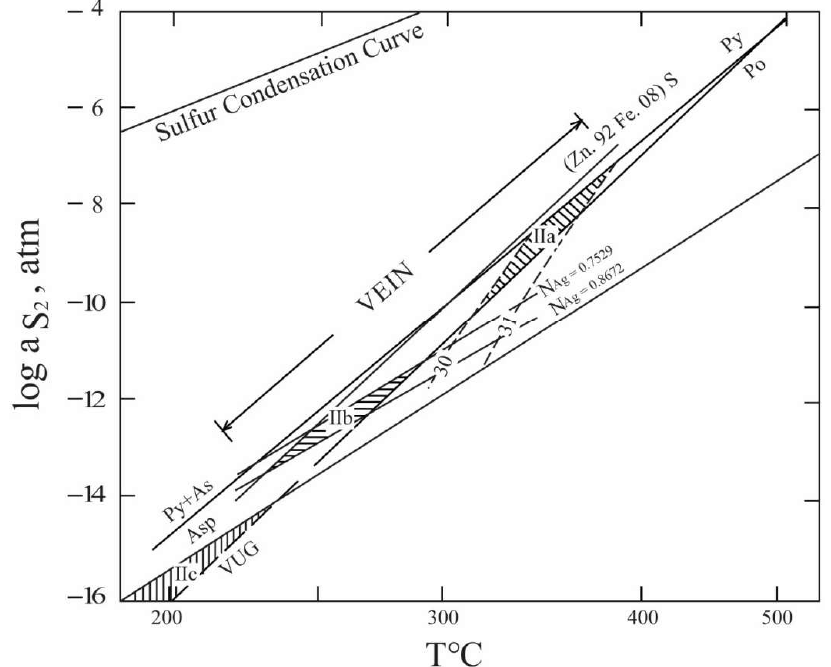
Figure 11. Sulfur fugacity versus temperature diagram showing sulfidation reactions pertinent to Eunjeok mineral assemblages. Sulfur fugacity and temperature systematically decrease from stage IIA through IIB toward IIC. These decreases are interpreted to represent repeated incursions of meteoric waters into the hydrothermal system. N Ag = atomic fraction of silver in electrum. Abbreviations: Py = pyrite, As = arsenic, Asp = arsenopyrite, Po = pyrrhotite. Vein stage : The presence of the pyrite–arsenopyrite–pyrrhotite–sphalerite assemblage The maximum fO 2 condition of pyrite–pyrrhotite stability is at the pyrite–pyrrhotite– in the early mineralization (IIa) of the vein stage from the Eunjeok deposit restricts fS 2 to magnetite triple point. 6FeS + 2O 2 = Fe 3 O 4 + 3FeS